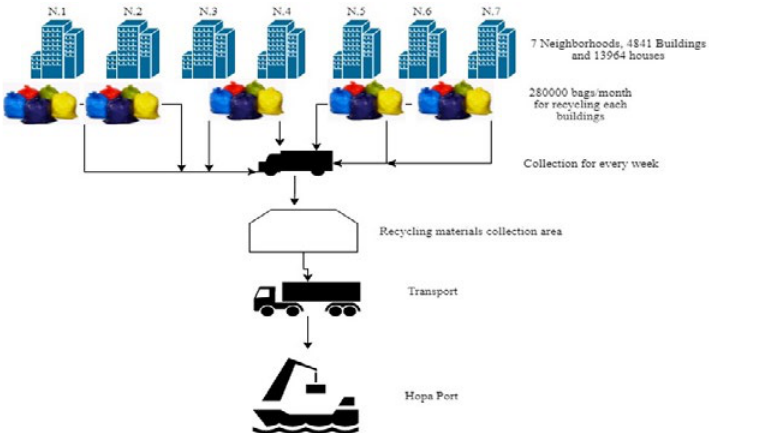
Fig. 10: Method CFH flow chart